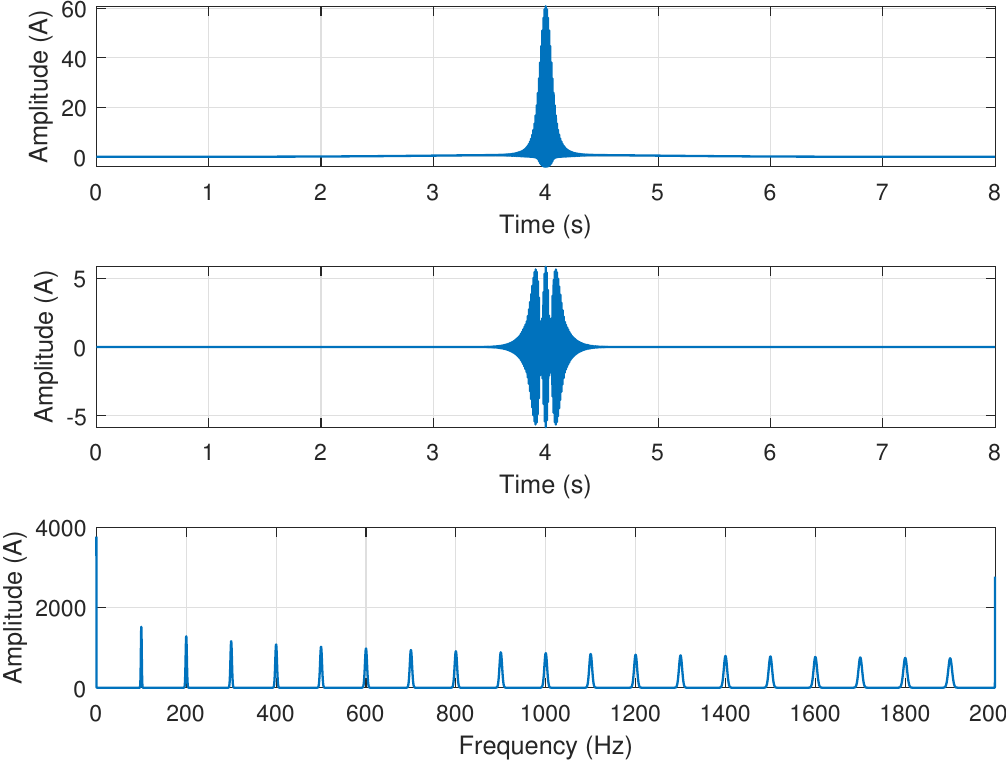
Figure 1. Multi-band window designed in Section 3 in the time domain (real part, top, imaginary part, middle) and in the frequency domain (bottom). This window contains 20 Gaussian windows, located in 20 adjacent frequency bands of 100 Hz, spanning linearly the range [ α = 1 – α =